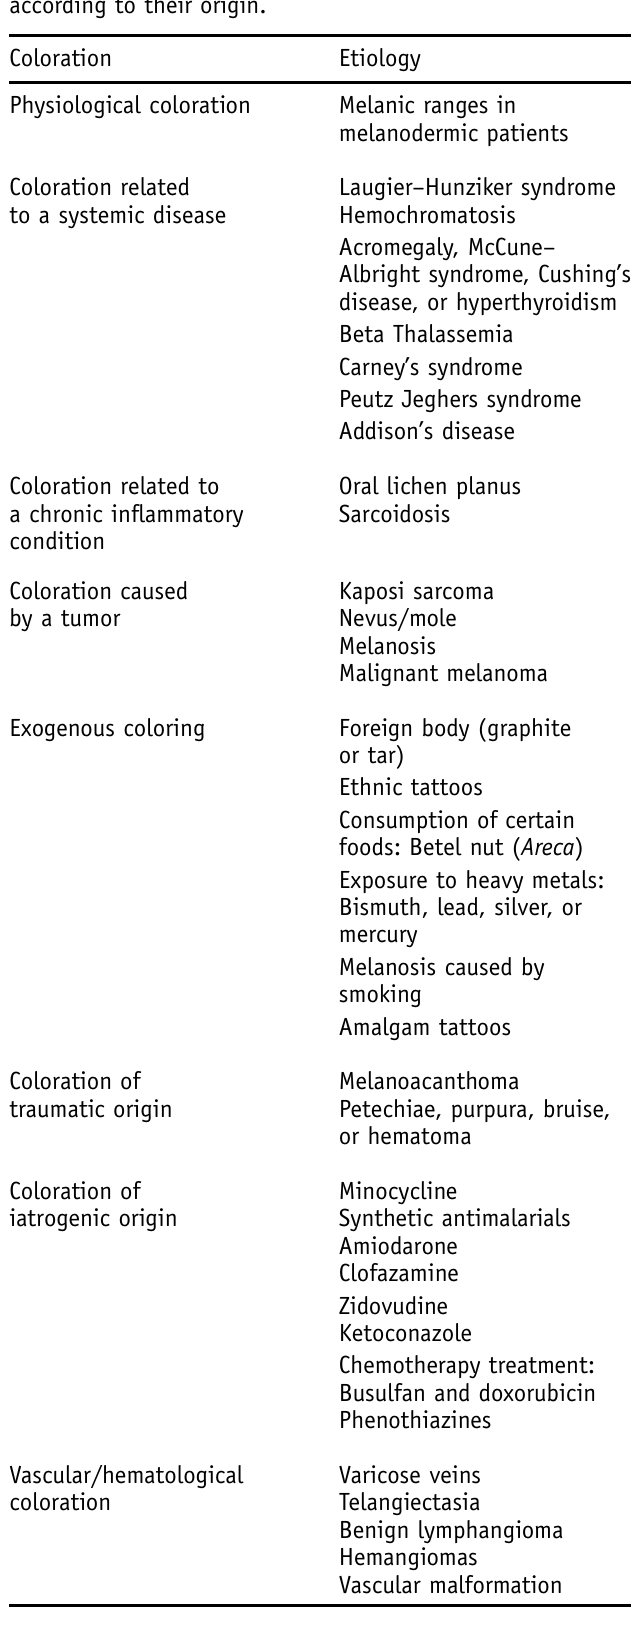
Table I. Causes of pigmented lesions of the oral mucosa according to their